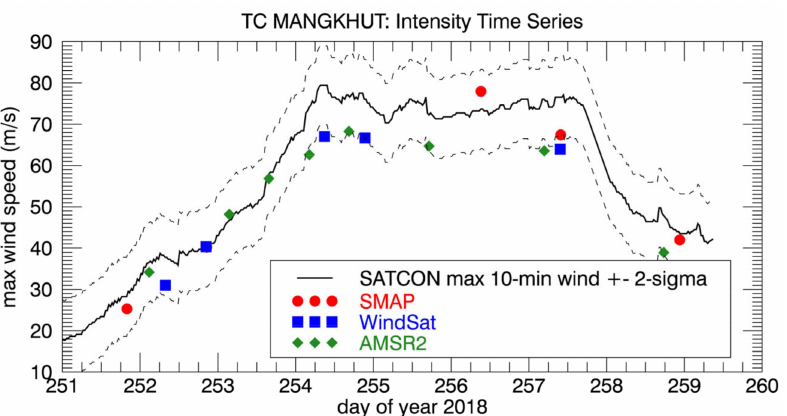
Figure 9. Intensity (maximum wind speed) time series of TC winds from SMAP (red circles), AMSR2 (green diamonds) and WindSat (blue squares) passes over Super Typhoon Mangkhut in 2018. The solid black line indicates the intensity time series of the University of Wisconsin SATCON data after scaling them to 10-min sustained winds. The dashed black lines indicate the +/ − 2-sigma deviation of the SATCON data.